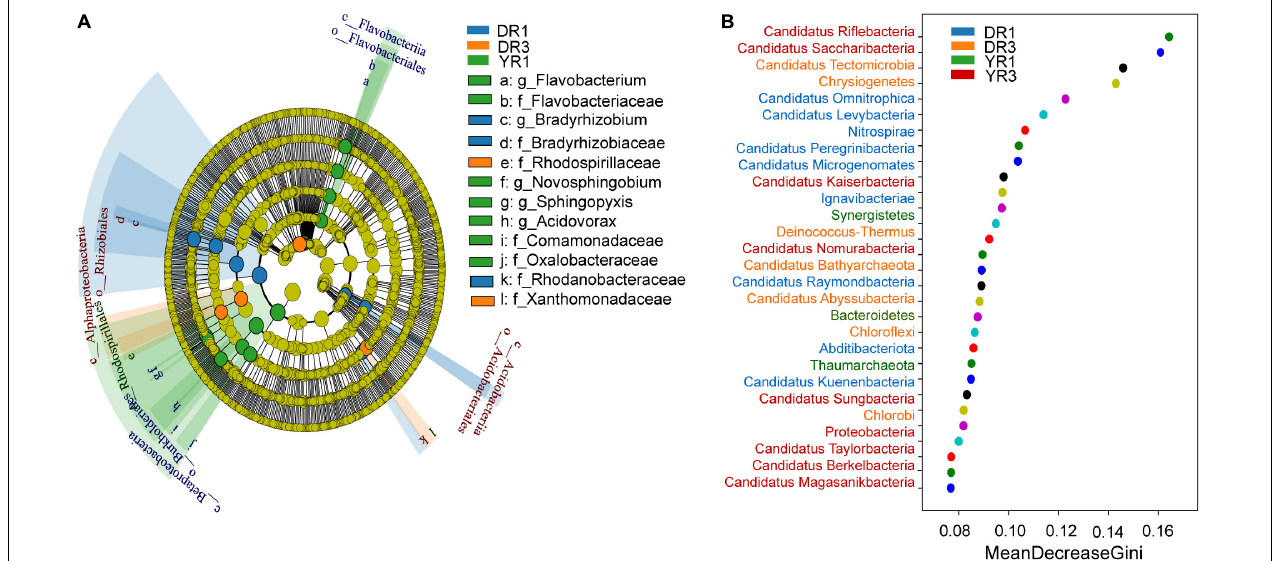
FIGURE 6 | The LEfSe and random forest analyses of microbial communities. (A) The cladogram of the microorganisms based on the LEfSe analysis. The threshold value of LDA is 2. The blue, orange, and green taxonomies represent the biomarkers playing an important role in the non- and severely diseased group from Dali and non-diseased group from Yuxi, respectively. No such taxonomy existed in the severely diseased group from Yuxi. The relative abundance of the yellow one showed no significant difference ( p ≥ 0.05). (B) The random forest analysis of the microorganisms at the phylum level. DR1 and DR3 represent the rhizosphere soil in the non- and severely diseased group from Dali, respectively. YR1 and YR3 represent the corresponding samples from Yuxi.